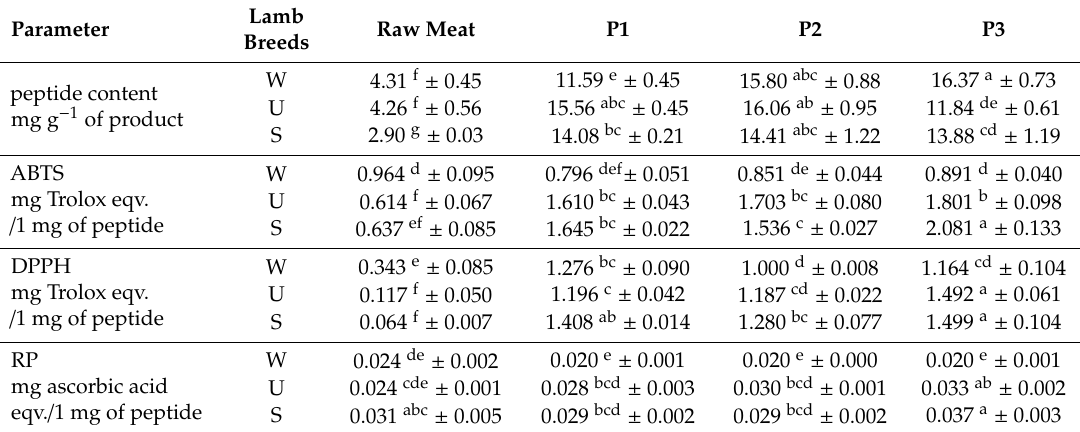
Table 3. Peptide content and antioxidant activity of lamb raw meat and